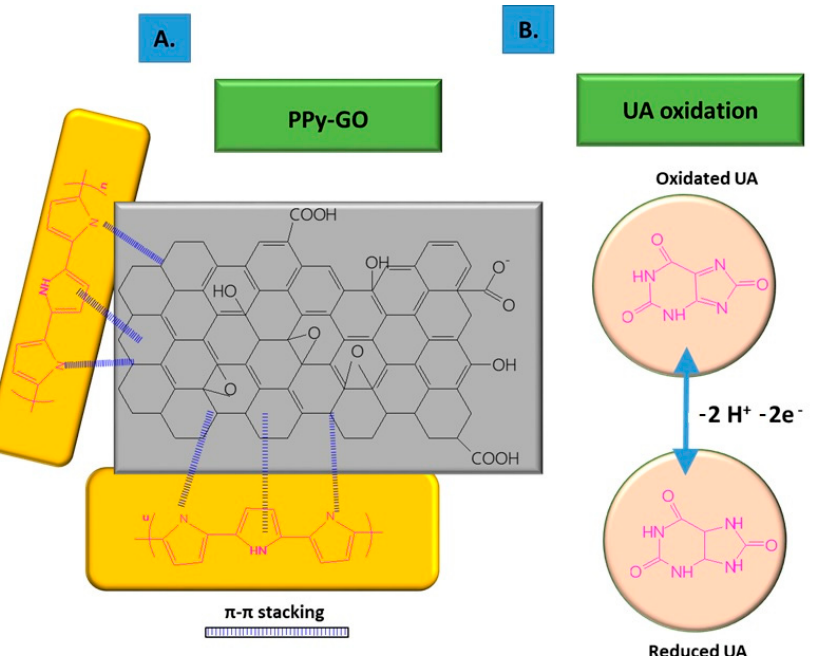
Figure 1. Non-covalent functionalization of GO with PPy inside the composite ( A ); and UA oxidation process at the surface of the composite deposited onto ES ( B ).